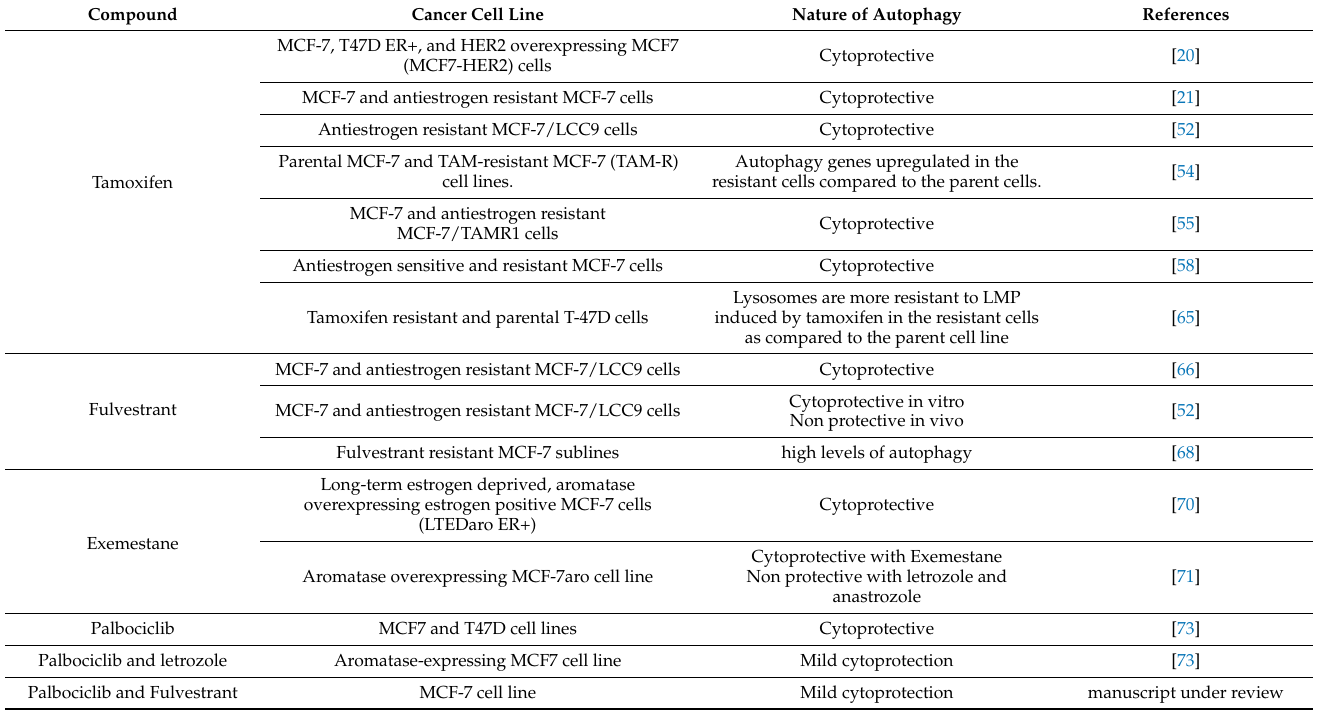
Table 1. Various functional roles of autophagy in response to endocrine